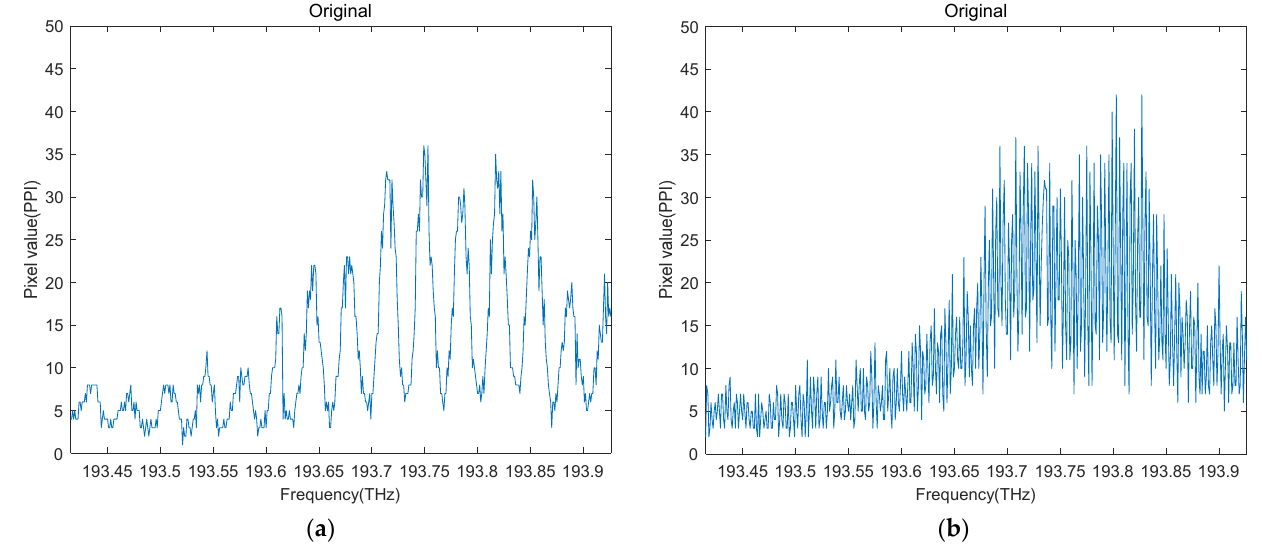
Figure 7. ( a ) Mode field intensity change of 10 m TMF; ( b ) mode field intensity change of 100 m TMF. After data collecting, the fast Fourier transform is applied in these two datasets, and the relationship curve between beat amplitude (dB) and DMGD (ps) are obtained from them, respectively, as Figure 8a,b shows.